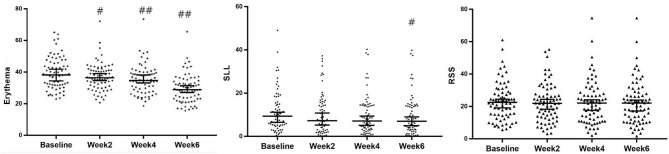
Evolution of erythema, SLL, and RSS of VISIA at baseline and 2, 4 and 6 weeks after treatment (median with 95%CI). #P < 0.05; ##P < 0.001. SLL, superficial lipid level surface; RSS, roughness of skin.